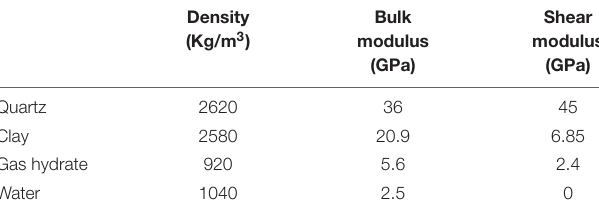
TABLE 1 | Properties used in rock physical modeling.